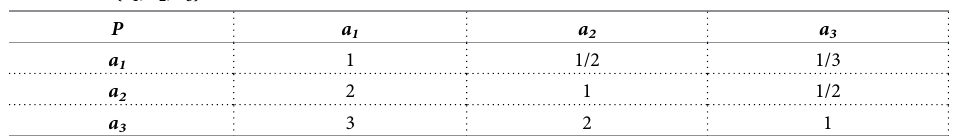
Table 5. P ⬅ { a 1 , a 2 , a 3 }.